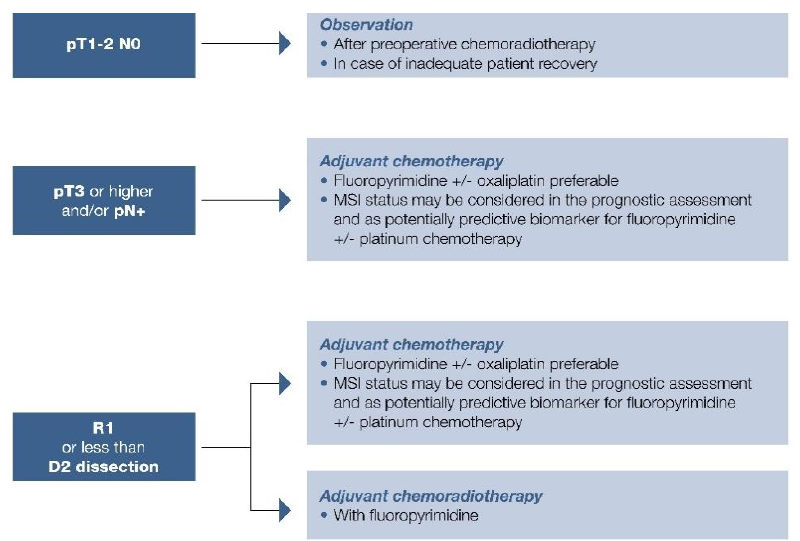
Figure 3. Treatment options for fit patients with resected gastric or gastroesophageal junction adenocarcinoma. MSI, microsatellite instability.